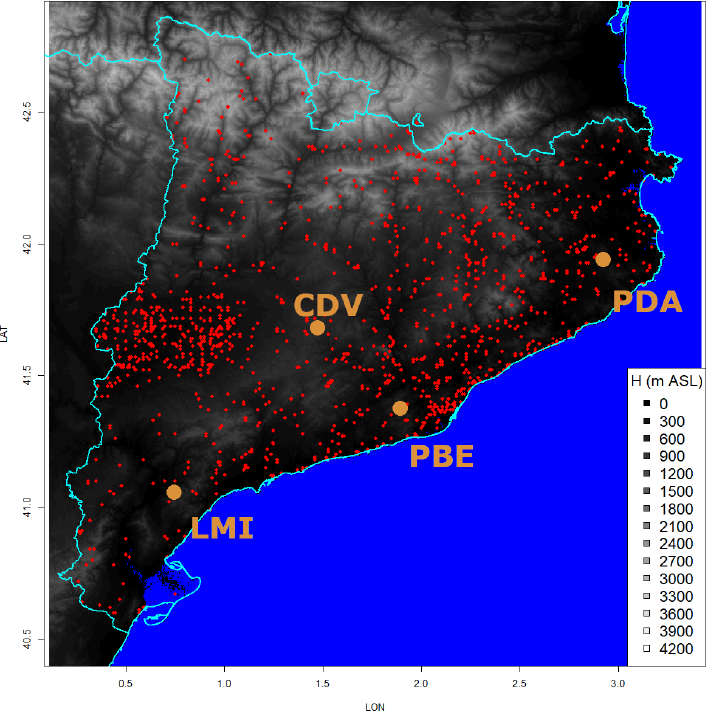
Figure 1. Map with all the daily hail registers (red points) for the period 2004 to 2022. The orange dots indicate the locations of the radars of the Network of the Servei Meteorològic de Catalunya.